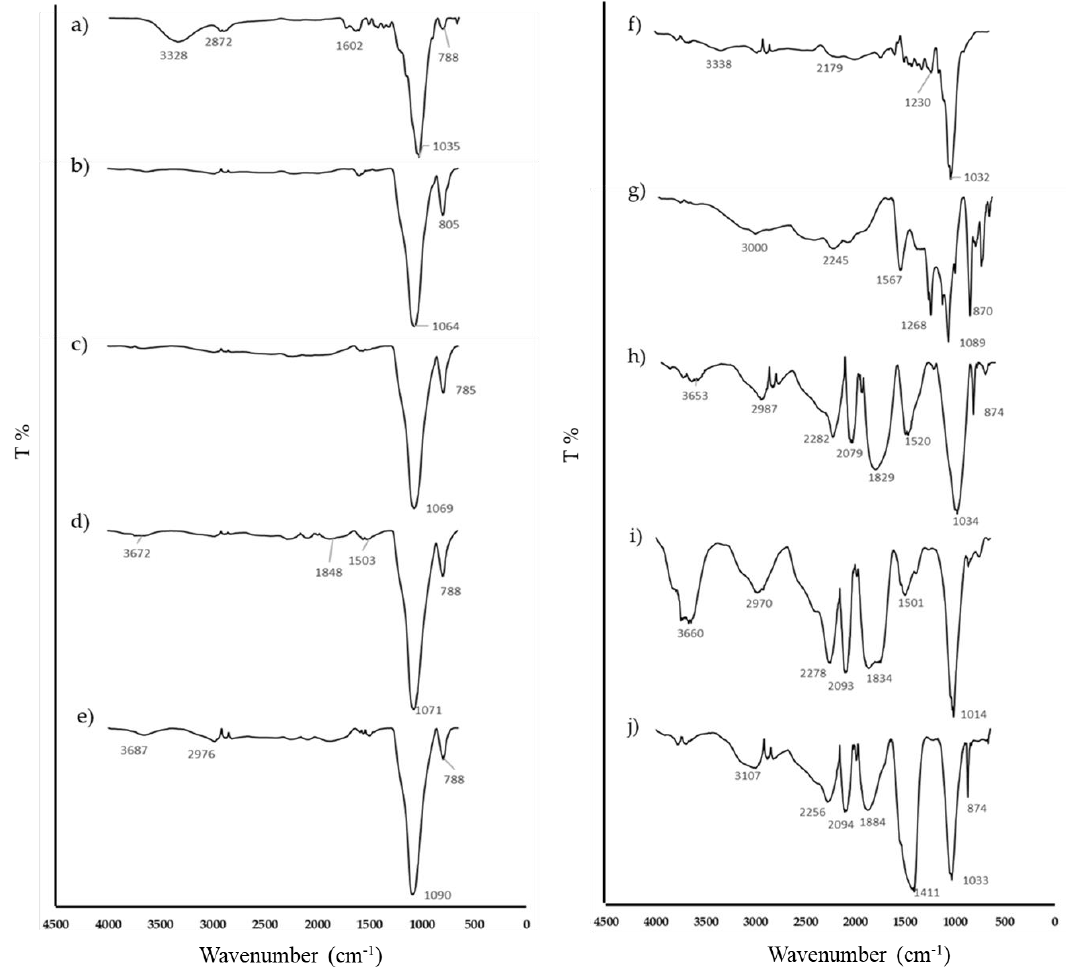
Figure 2. FTIR spectra for rice husk derived biochar ( a ) RH Raw, ( b ) RH550, ( c ) RH650, ( d ) RH750, ( e ) RH850; rubber wood derived biochar ( f ) RW Raw, ( g ) RW550, ( h ) RW650, ( i ) RW750, ( j ) RW850.